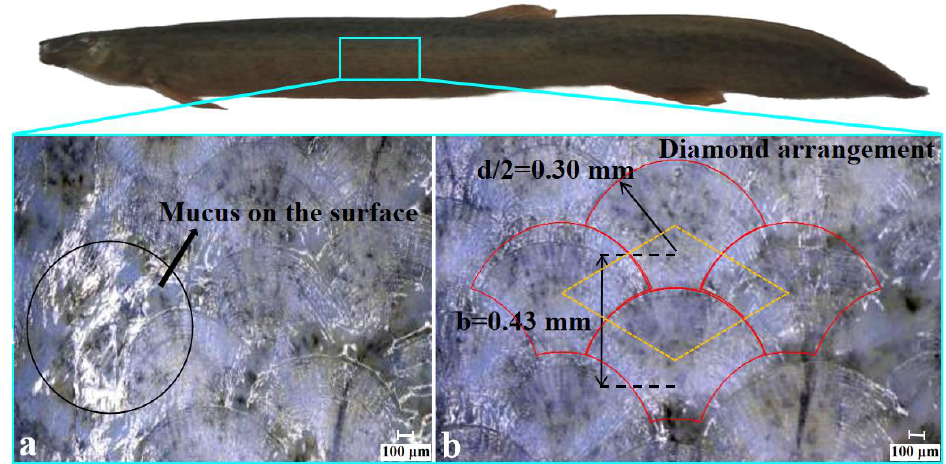
Figure 6. Arrangement of the loach scales. ( a ) Mucus on the scales; ( b ) Size and arrangement of scales after removing the mucus.